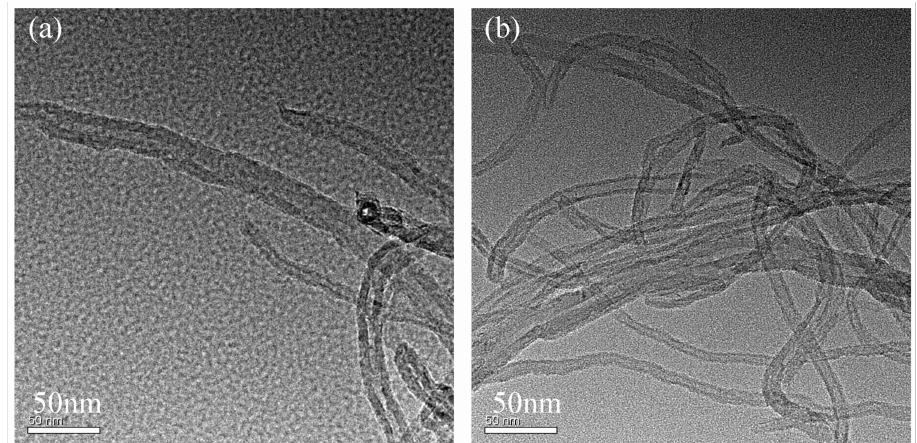
Figure 6. TEM images of ( a ) MWCNTs-COOH; ( b ) PEK-C-OH-g-MWCNTs-COOH.